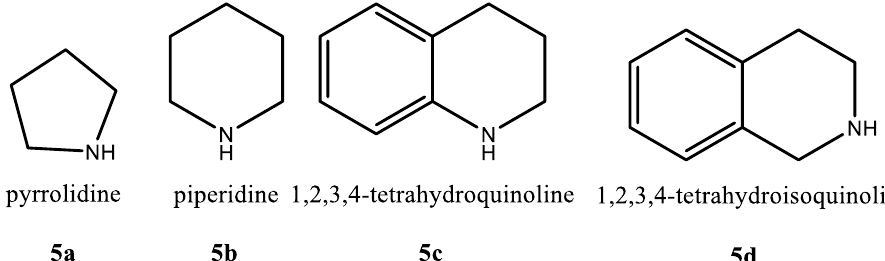
Figure 3. Secondary amines took place in the acylation reaction.